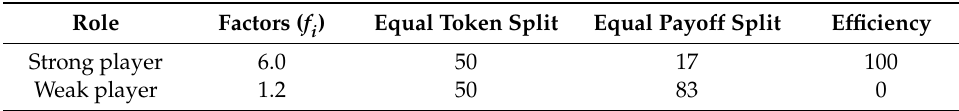
Table 1. Numerical value of fairness